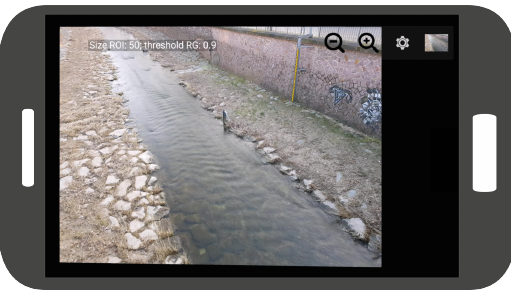
Figure 3. Workflow of event-based camera gauging using smartphones.